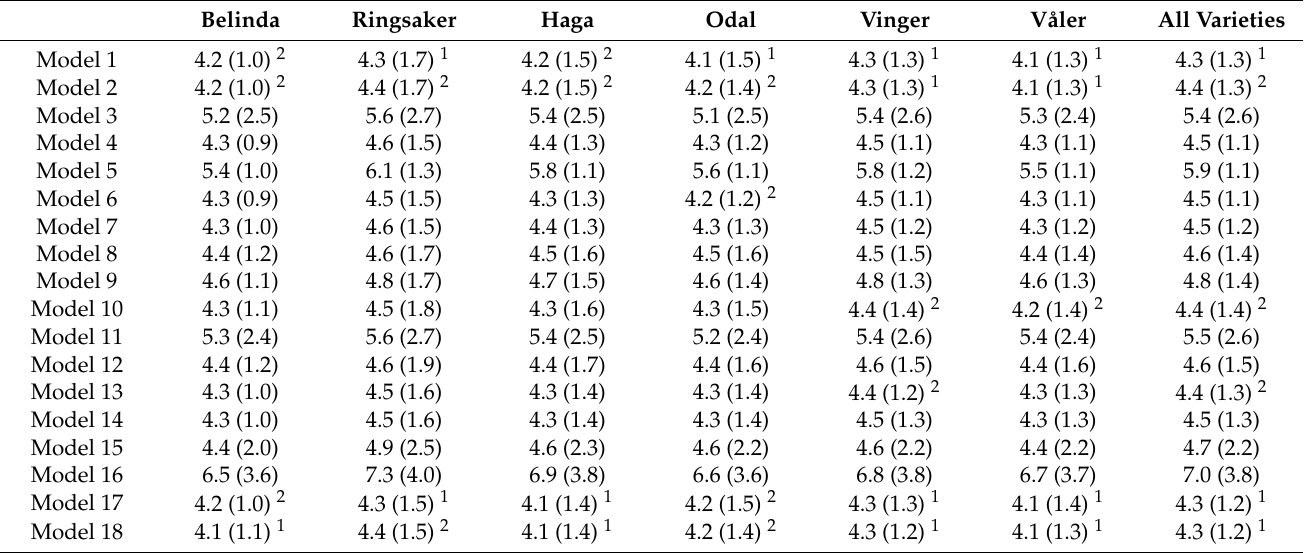
Table 1. Estimated root mean square error of validation (RMSEV) of the different models fit to validation data from the varieties Belinda, Ringsaker, Haga, Odal, Vinger and Våler separately and for all 13 varieties included in this study merged given as mean value (and standard deviation) over the splits in the cross site-year